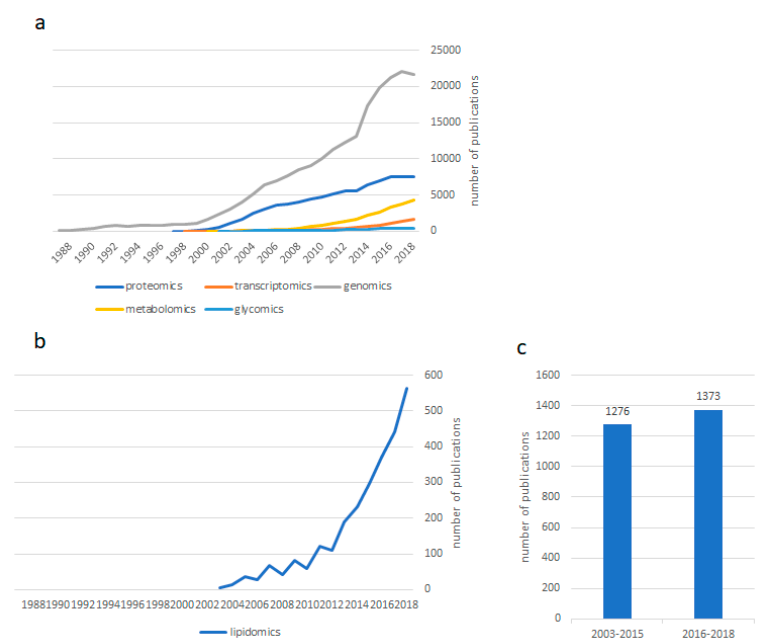
Figure 1. ( a ) Number of listed publications in PubMed over time using the corresponding “omic” discipline name as the keyword. ( b ) Number of listed publications in PubMed over time